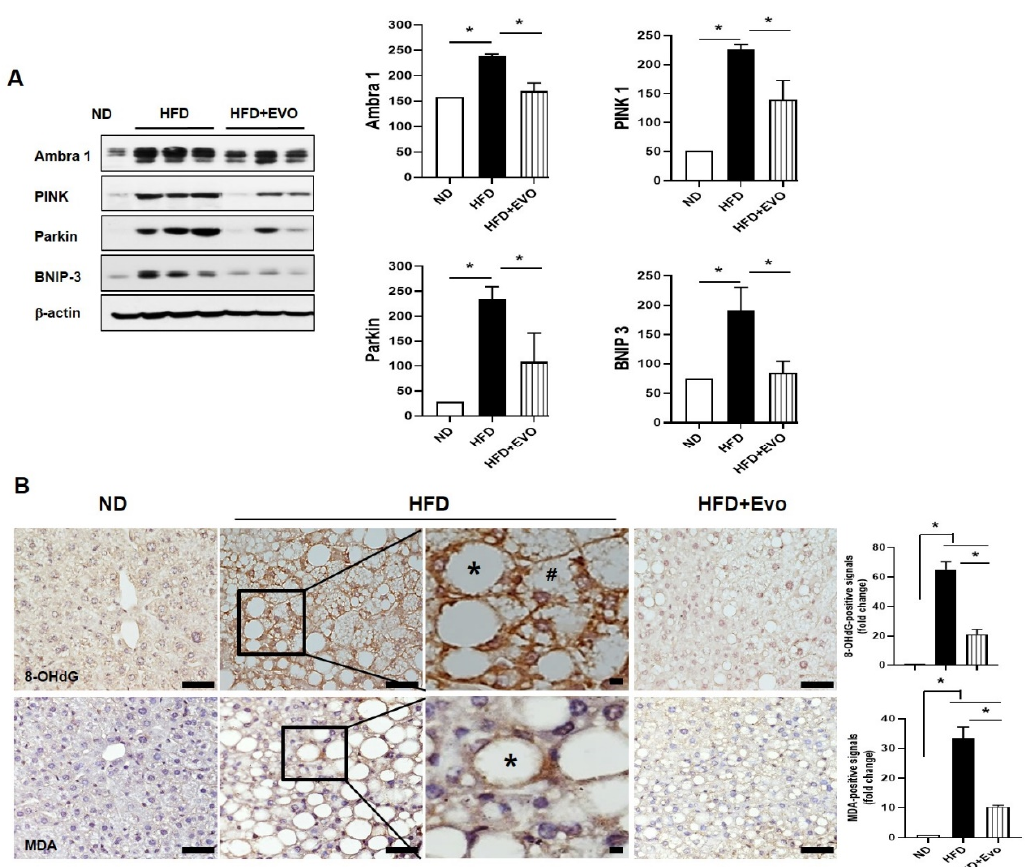
Figure 5. Effect of evogliptin on HFD-induced hepatic mitophagy and oxidative stress: ( A ) the liver tissue lysates from each group were examined by immunoblot with antibodies against mitophagy markers. Each expression is shown as mean ± SEM. * p < 0.05. ( B ) Representative immunohistochemical staining for 8-hydroxydeoxyguanosine (8-OHdG) and malondialdehyde (MDA) in liver sections from each group. Scale bar, 100 µ m for 8-OHdG and 50 µ m for MDA. Oxidative stress, as indicated by 8-OHdG and MDA, was elevated by HFD and decreased by Evo. HFD: high-fat diet; ND: normal diet; # microvesicular steatosis; * macrovesicular